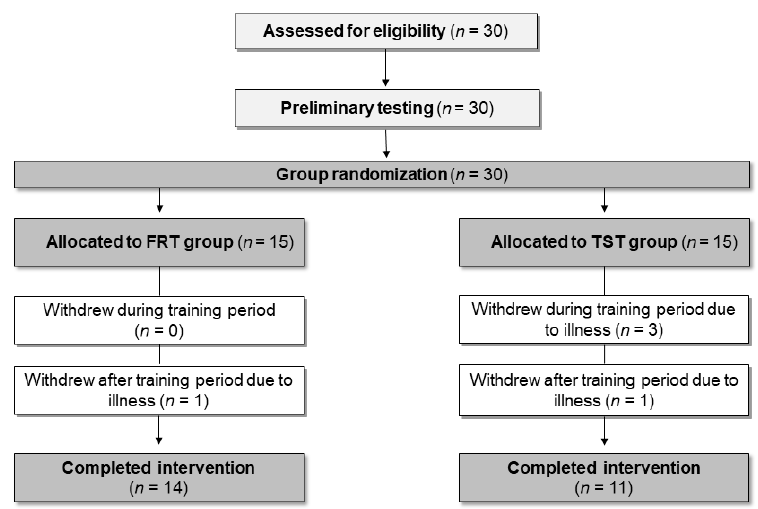
Figure 1. Flowchartoftheparticipant’sprogressfromeligibilityassessmenttocompletionofintervention.